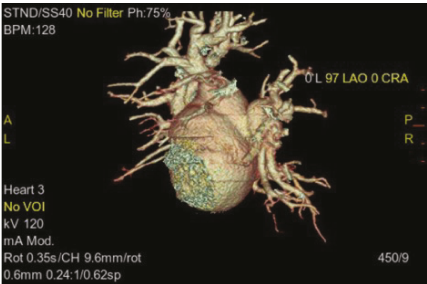
Figure 3: CTA of the pulmonary veins at 97 degrees steep LAO view showing there is no left atrial appendage on the heart surface.